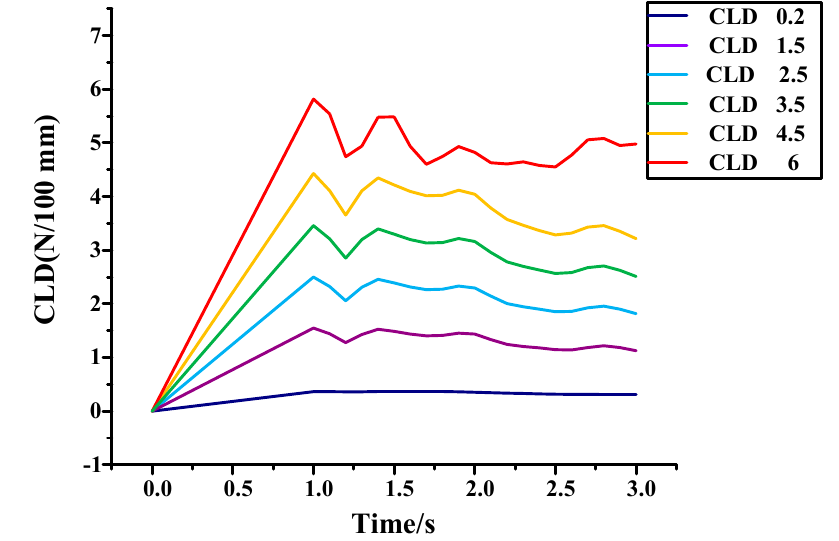
Figure 29. Simulation analysis of different CLD of inner belt.